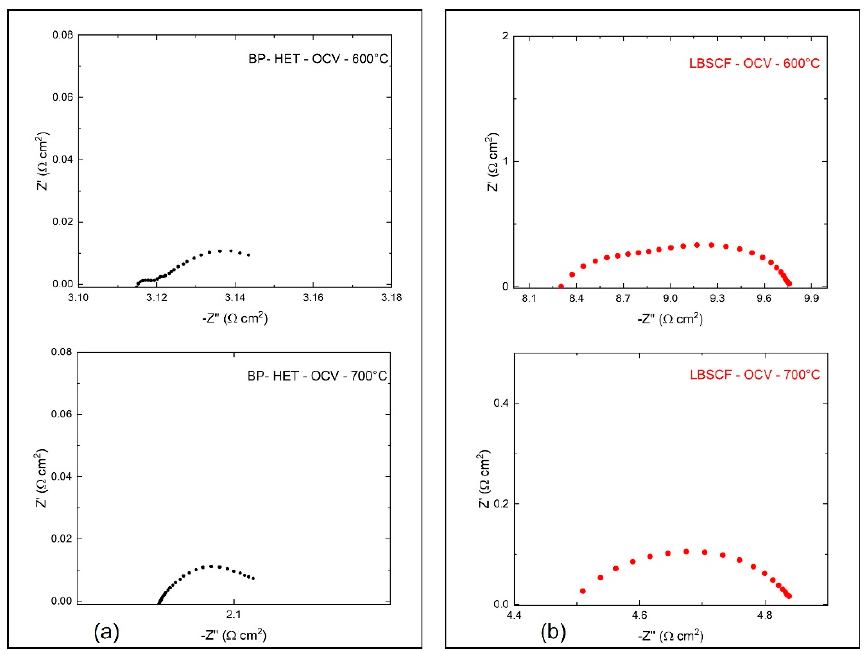
Figure 7. Impedance spectra acquired at 600 °C and 700 °C in air for BP-HET (black dots ( a )) and LBSCF (red dots ( b )).